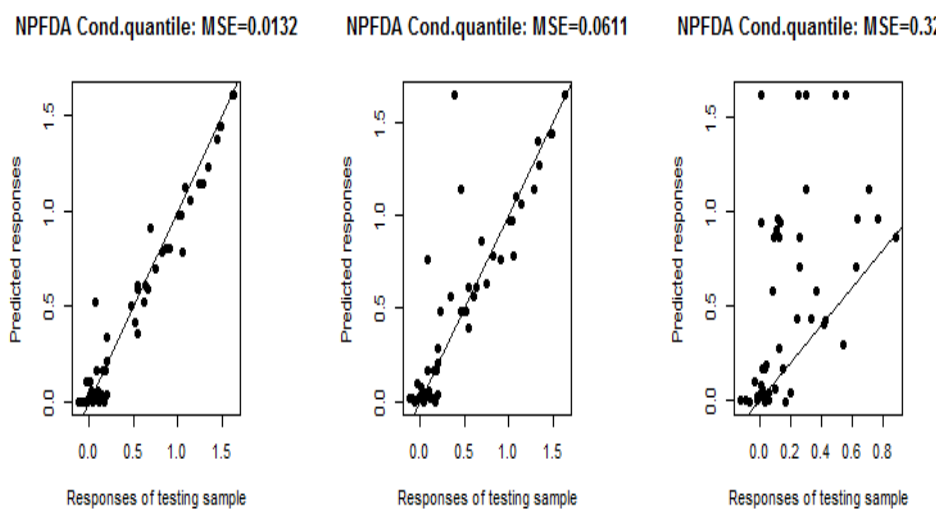
Figure 5: CR ∼ 3.5% , MSE=0.0132 on the left, CR ∼ 18% , MSE=0.0611 on the center, and CR ∼ 48% , MSE=0.3214 on the right